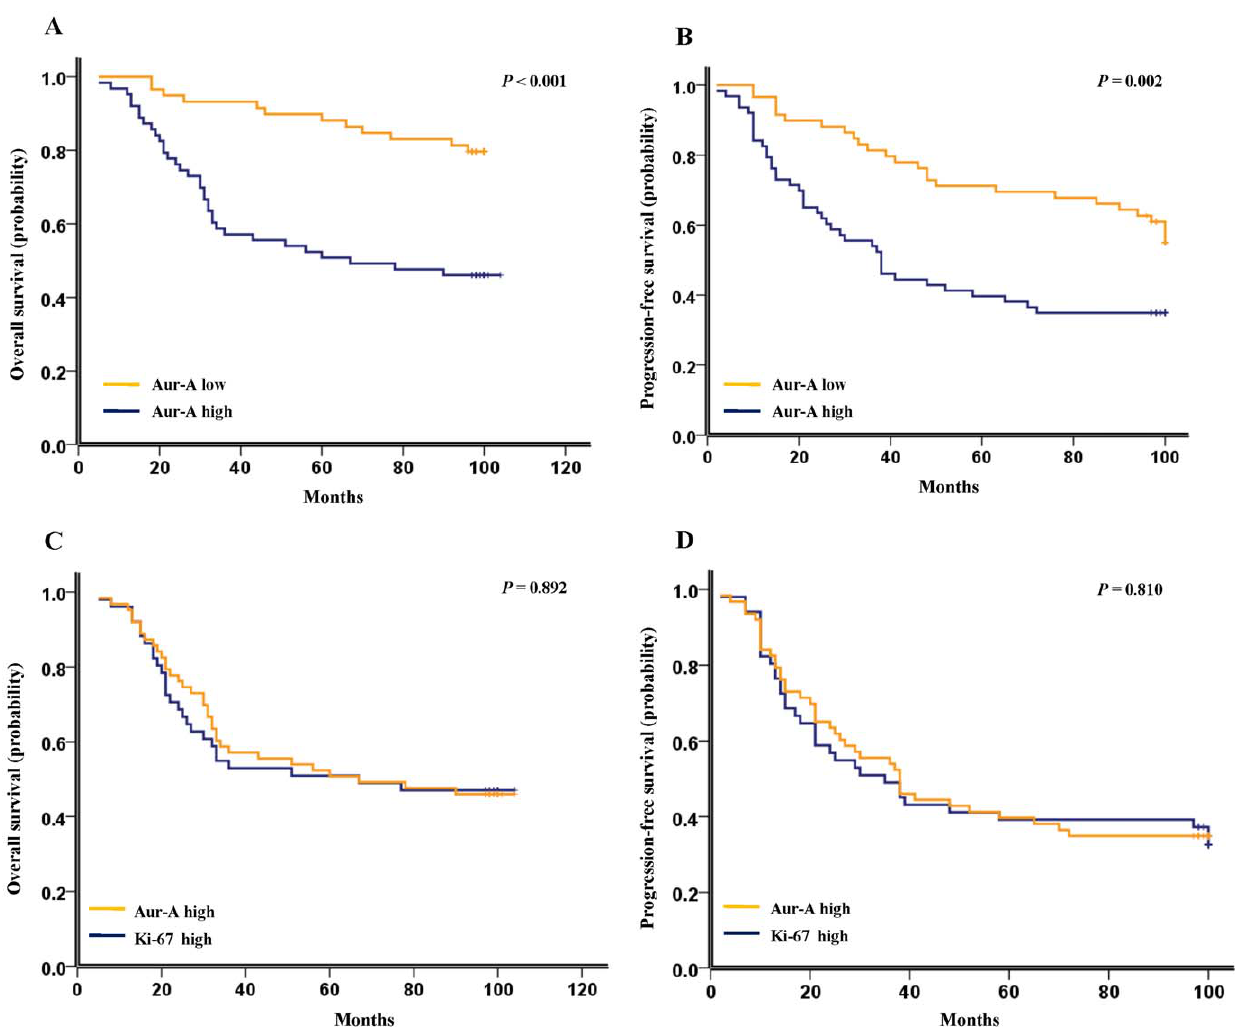
Figure 2. Kaplan-Meier survival analysis of Aur-A and Ki-67 expression in TNBC patients (n=122). (A) High expression of Aur-A was closely correlated with inferior overall survival, and (B) progression-free survival in TNBC patients. The median survival time for patients with high and low expression of Aur-A was 67.5 months VS. 110.0 months for OS ( P , 0.001), and 38.4 months VS. 100.0 months for PFS ( P =0.002), respectively. (C) TNBC patients with high expression of Ki-67 showed similar OS and (D) PFS with those showing high Aur-A expression. The median survival time for patients with high Ki-67 expression and high Aur-A expression was 67 months VS. 67 months for OS ( P =0.892), and 36 months VS. 38 months for PFS ( P =0.810),